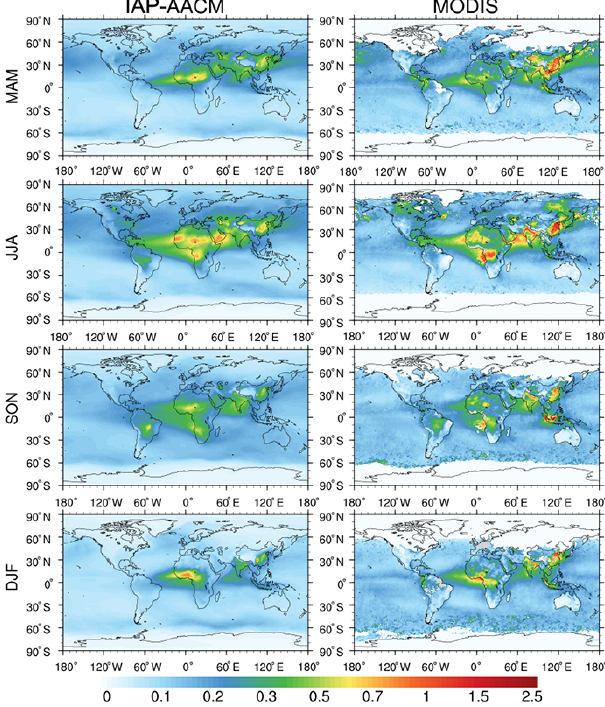
Figure 10. Seasonal mean AOD from IAP-AACM (left column) and MODIS (right